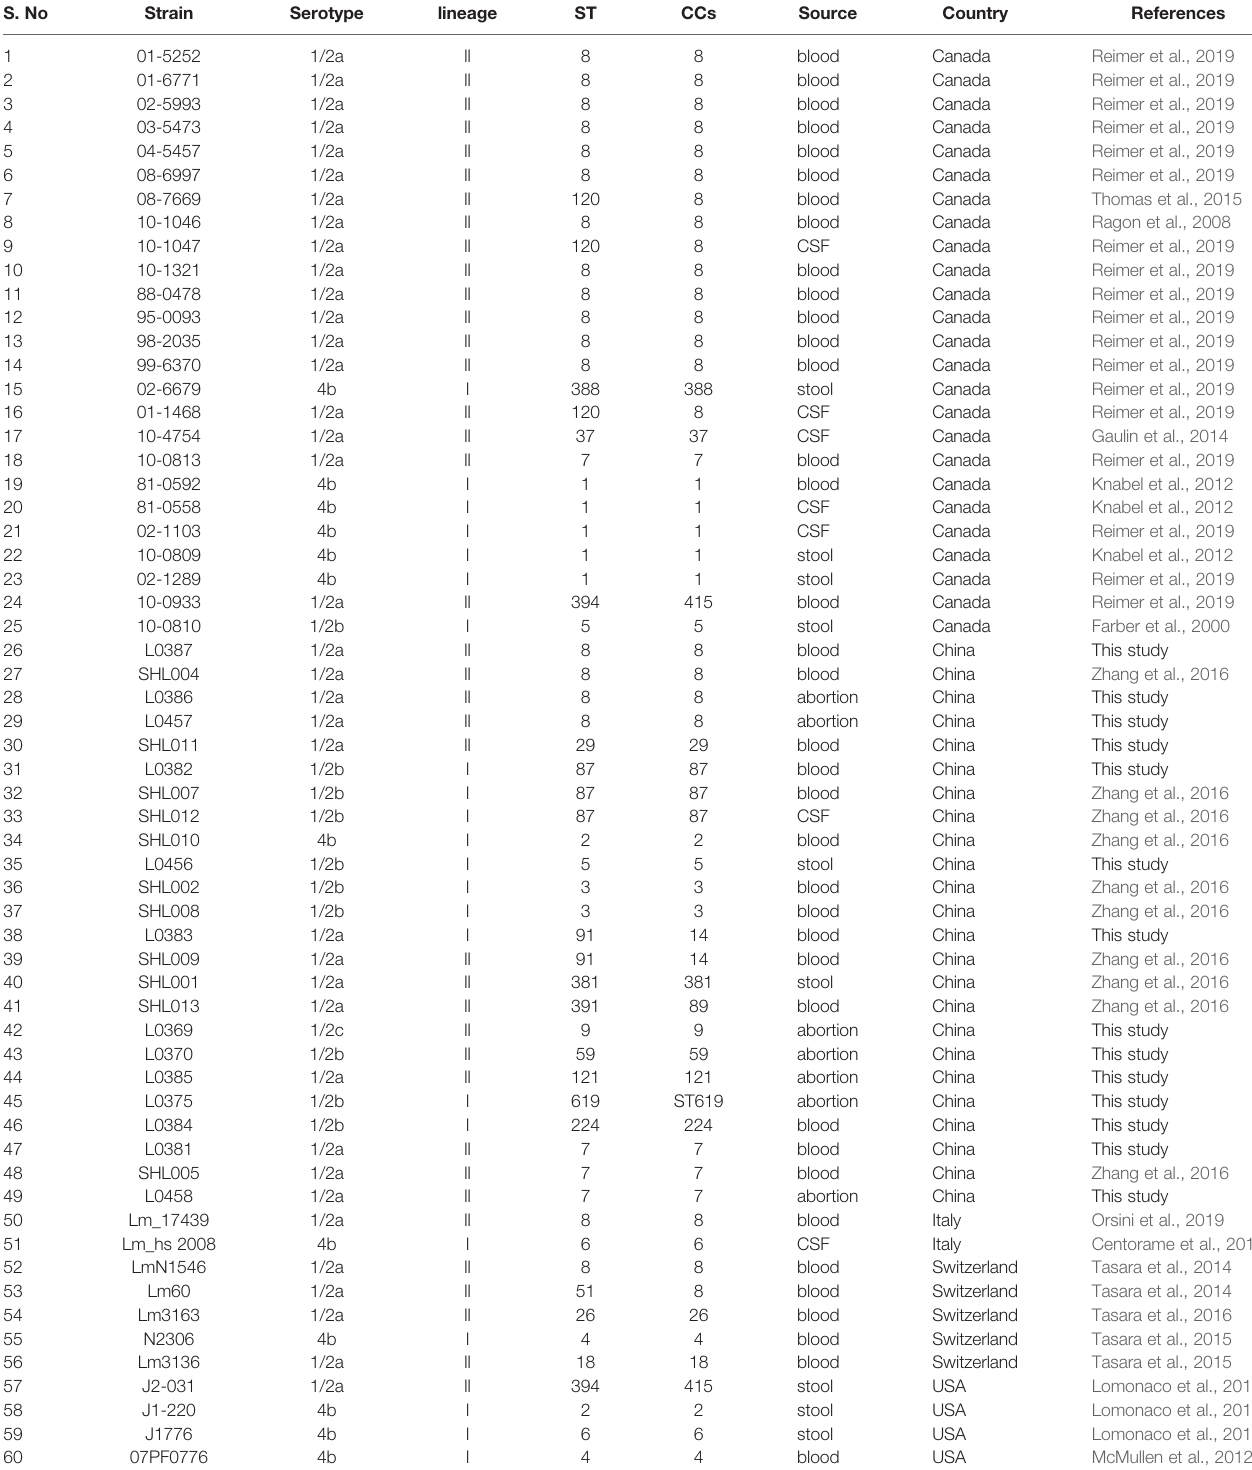
TABLE 1 | A list of 60 Listeria monocytogenes clinical isolates examined in this study. S.